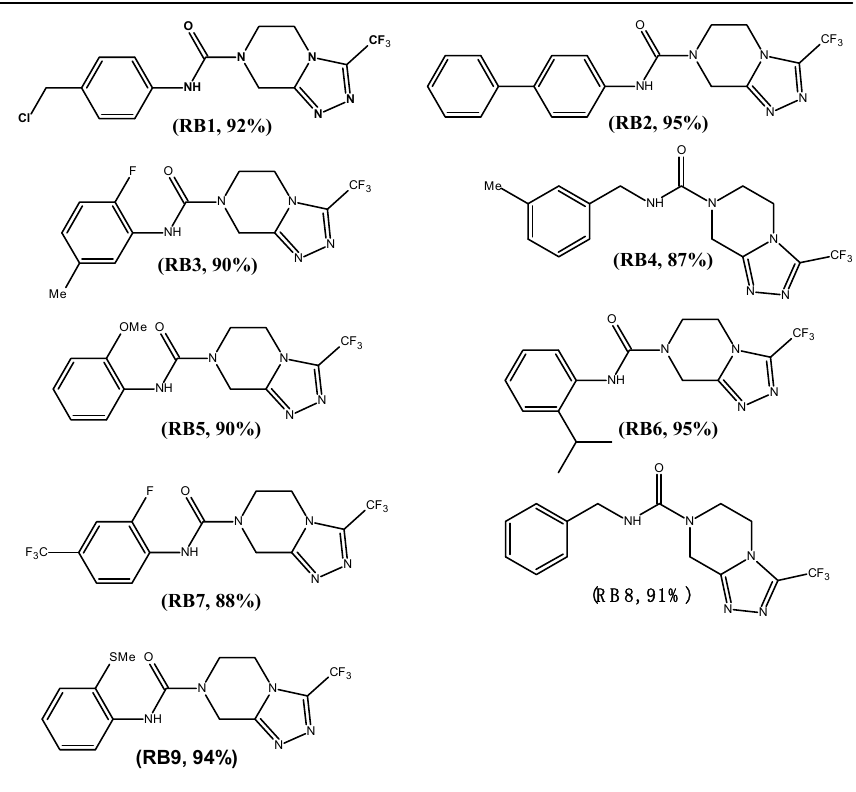
Figure 1. Synthesis of 3-trifluoromethyl-5,6-dihydro-[1,2,4]triazolo pyrazine derivatives.